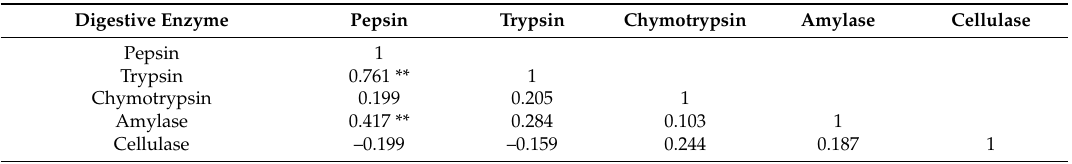
Figure 2. Ontogenic changes in specific activities of pepsin ( a ), trypsin ( b ), chymotrypsin ( c ), amylase ( d ), and cellulase ( e ) in mealworm larvae. Data are expressed as mean ± SEM from triplicate measurements. Significant differences between treatments are indicated by different superscripts ( p < 0.05). DAH stands for days after hatching. Table 1. Pearson correlation coefficients ( r ) of time profiles of digestive enzyme specific activities, detected in mealworm larvae ( n = 39).